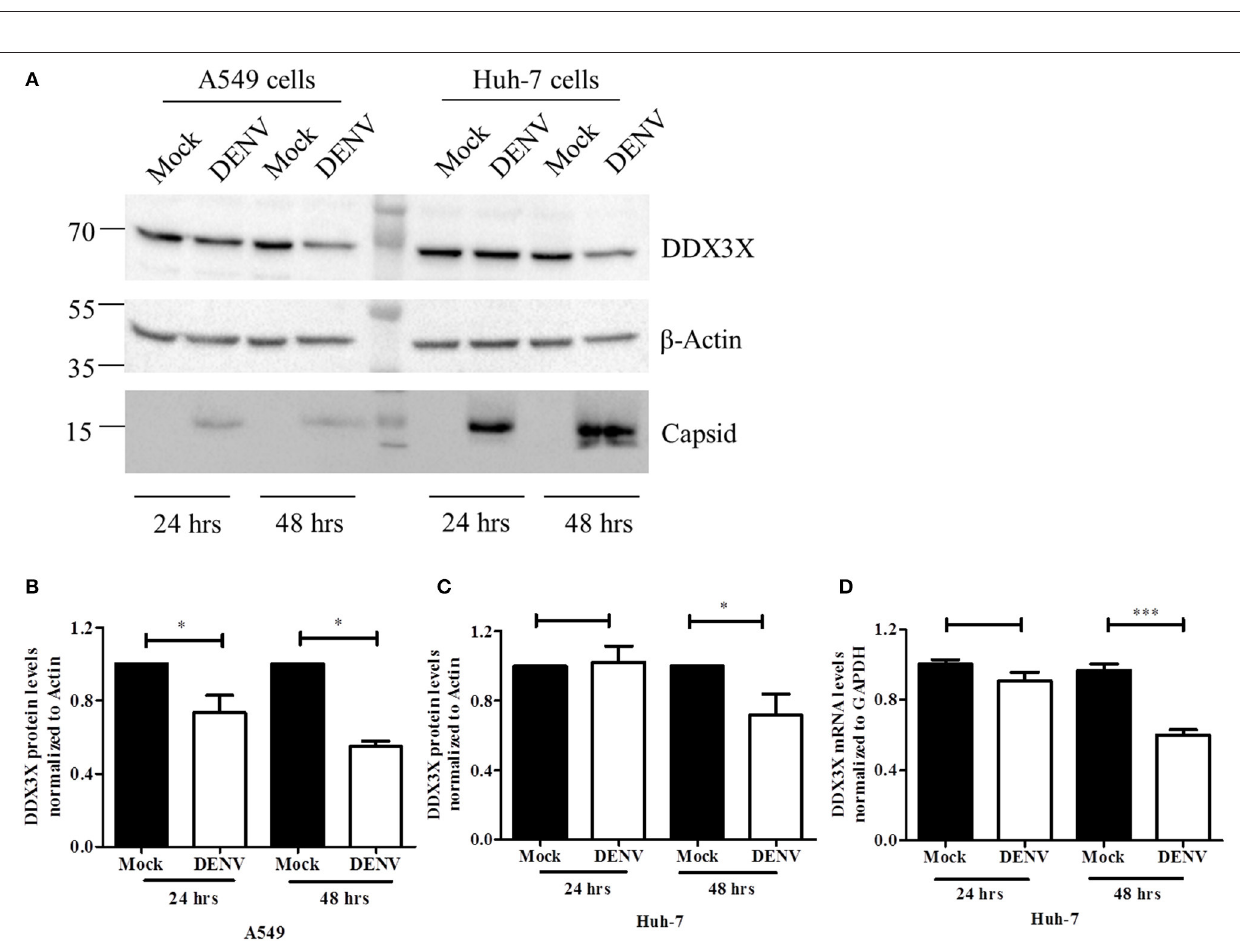
FIGURE 3 | DENV down-regulates DDX3X at later stages of infection. A549 and Huh-7 cells were infected with DENV at 3 MOI. Cells were collected at 24 and 48h pi for either lysate preparation or for total RNA isolation. (A) Cell lysates were used for western blot analysis for DDX3X, GAPDH and capsid in both cell lines. (B) . Densitometry quantitation of the blots for A549 cells ( n = 4). (C) Quantitation of blots for Huh-7 cells ( n = 4). (D) Total RNA was used to estimate mRNA levels of DDX3X by real-time PCR from 3 independent experiments performed in triplicates ( n = 9). Data is represented as mean ± SEM. * P < 0.05 and *** P < 0.0005, ns = not